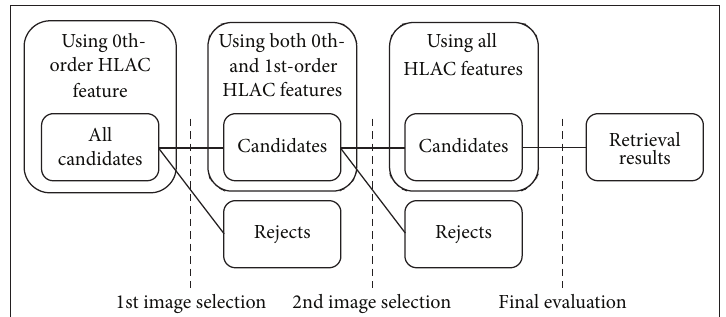
Figure 10: Stepwise image selection for all candidate images.